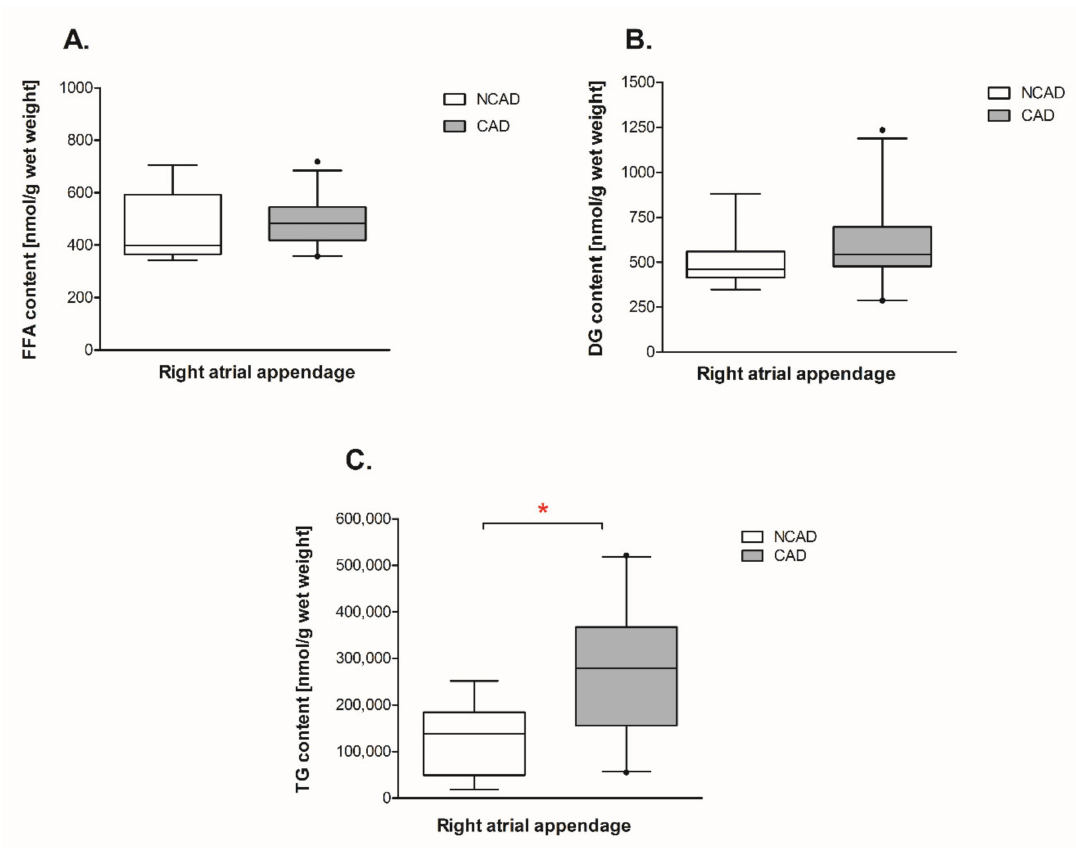
Figure 9. Myocardial content of ( A ) free fatty acids (FFA), ( B ) diacylglycerols (DG) and ( C ) triacylglycerols (TG) in the coronary atherosclerosis (CAD, n = 24) and control (NCAD, n = 11) patients. The number of subjects with atherosclerosis studied was smaller than the number assayed for mRNA and protein expression due to the insu ffi cient amount of the muscle tissue available. Data are expressed as mean ± SEM. * p < 0.05 vs. control subjects. Table 2. TG—Fatty acid composition (nmol / g of wet tissue).